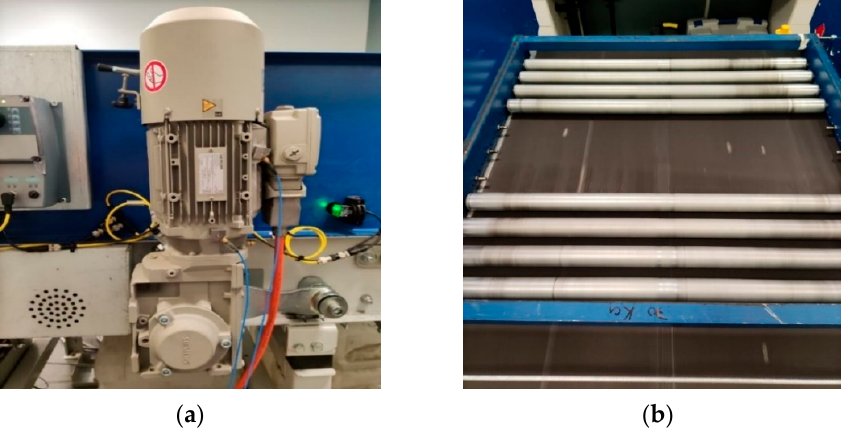
Figure 2. The conveyor belt system under investigation. ( a ) The gearmotor of the belt conveyor system, ( b ) The loaded belt conveyor system.